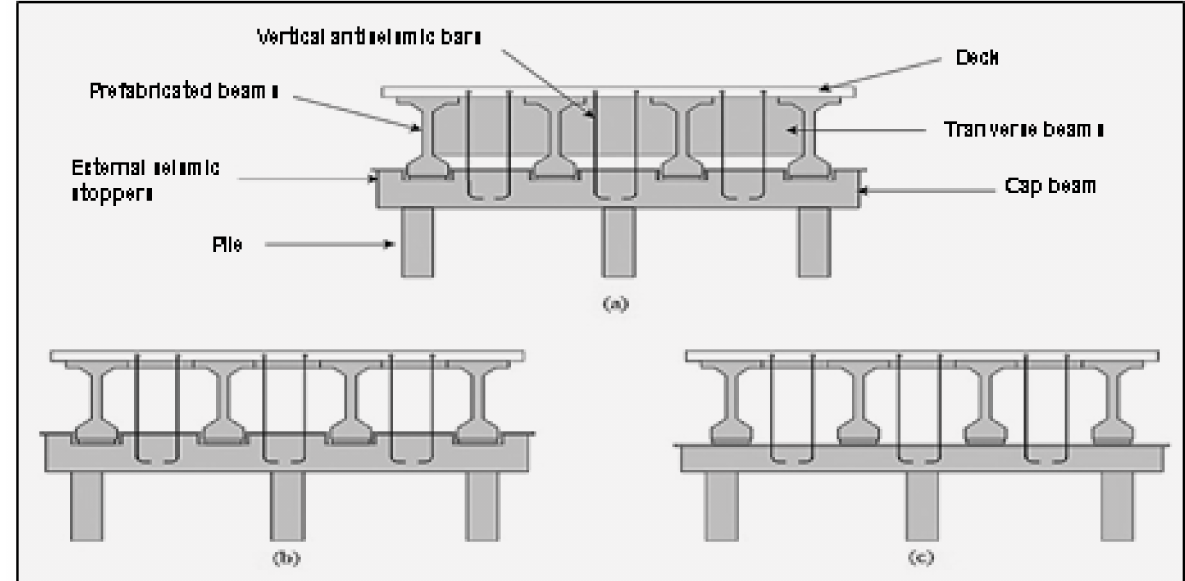
Figure 1. Original blueprint—typical section of Chilean bridges: ( a ) Typical section established by the Manual de Carreteras of Chile. ( b ) Section where the diaphragm was eliminated. ( c ) Section where seismic stoppers were